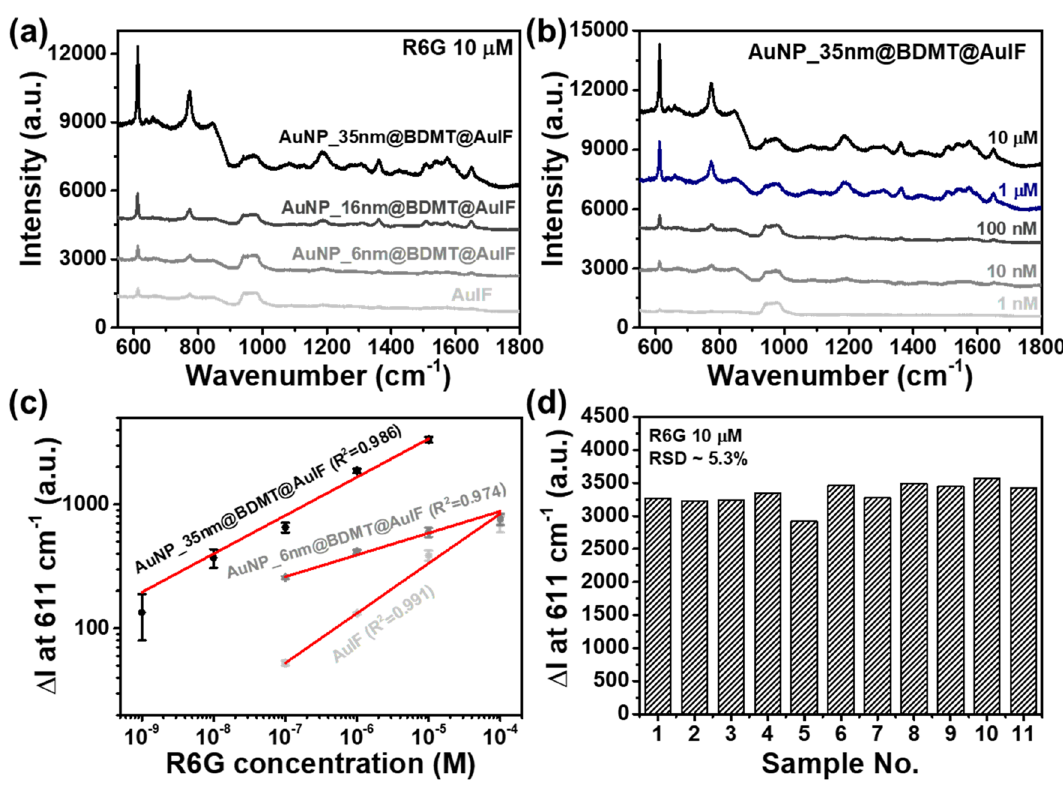
Figure 4. SERS performance of the AuNPs@BDMT@AuIF for R6G molecules. ( a ) Raman spectra for the AuIF and the AuNPs@BDMT@AuIF with different diameters of AuNPs at 10 μM of R6G concentration. The Raman signal of the AuNP_35nm@BDMT@AuIF sensor is about eight times higher than that of AuIF sensor. ( b ) SERS spectra of the AuNP_35nm@BDMT@AuIF sensor at R6G concentrations of 10 − 5 to 10 − 9 M. ( c ) Raman intensity at 611 cm − 1 as a function of the logarithmic concentration of R6G for the AuIF, the AuNP_6nm@BDMT@ AuIF, and the AuNP_35nm@BDMT@AuIF sensors. ( d ) Intensity distribution at 611 cm − 1 was evaluated for 11 different regions at 10 μM of R6G concentration for the AuNP_35nm@BDMT@AuIF